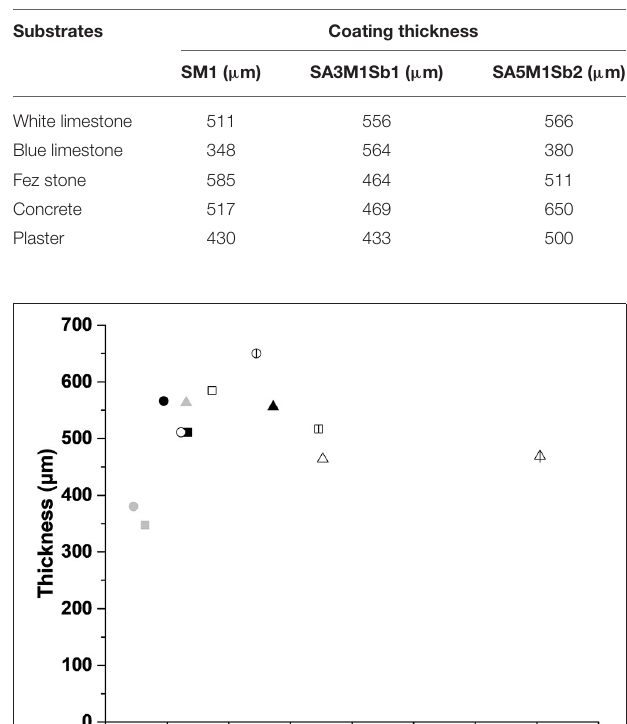
TABLE 4 | Thickness of the different coatings sprayed on the five substrates.